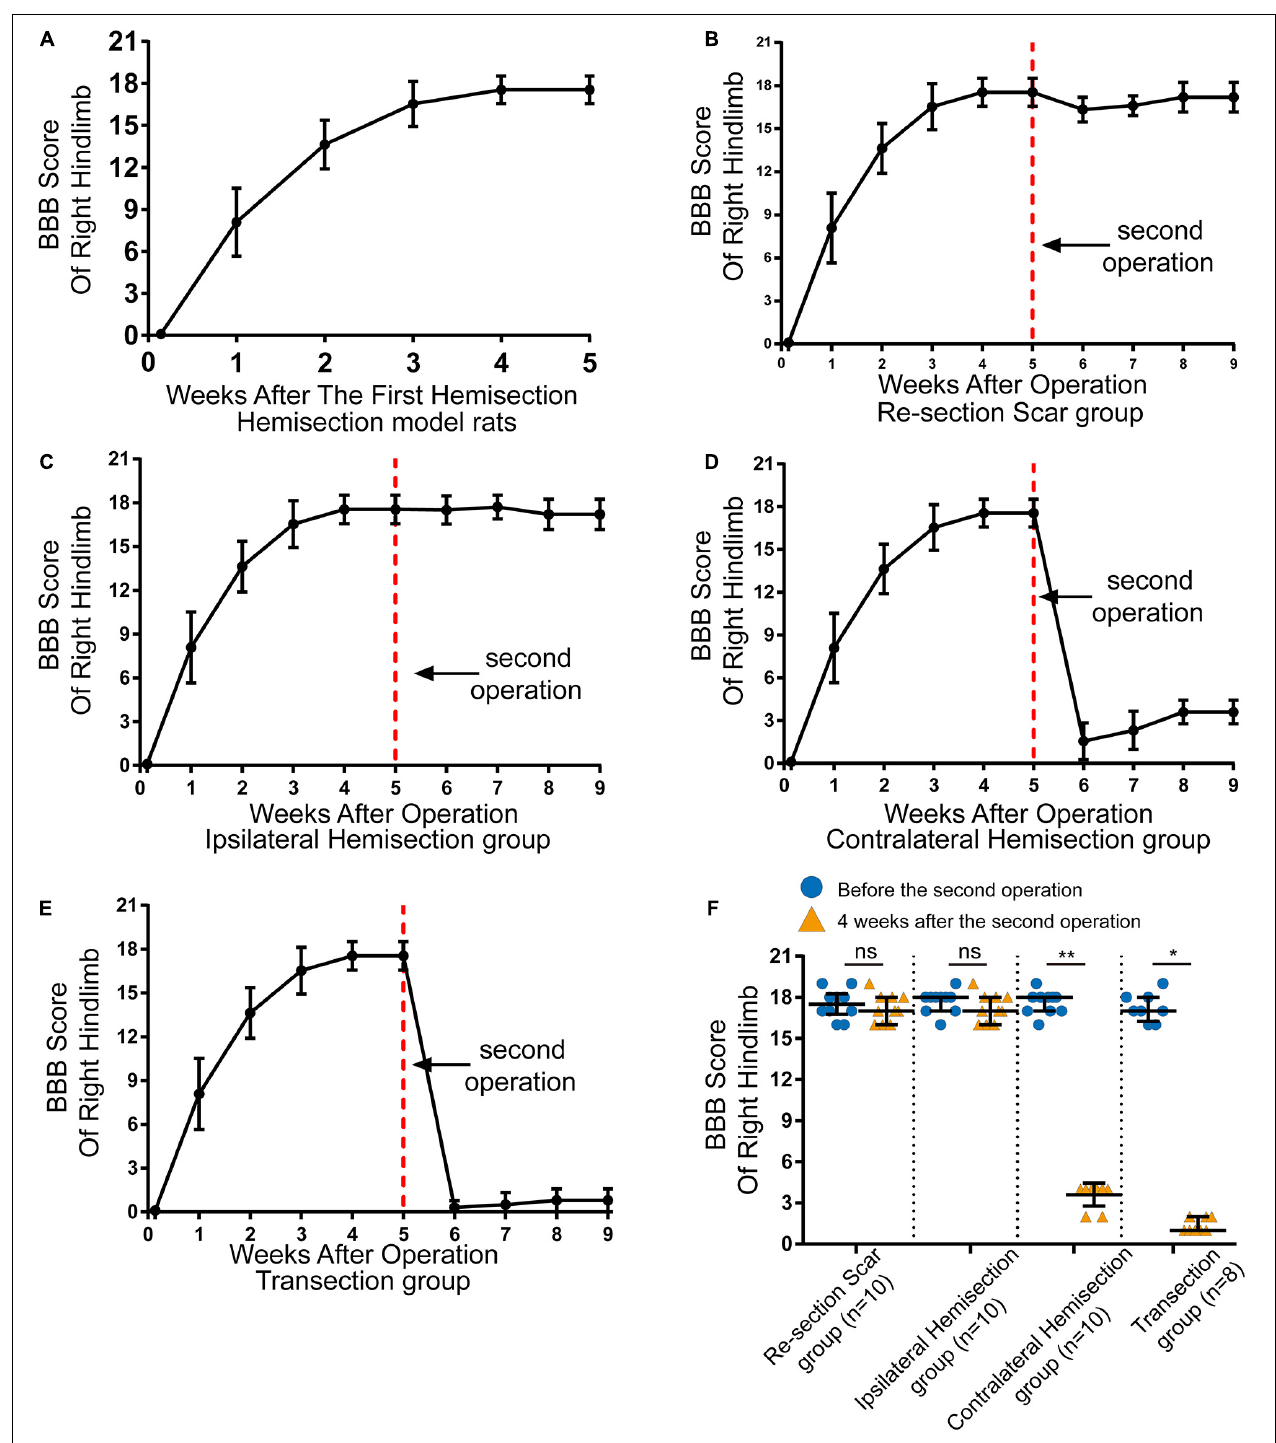
FIGURE 2 | Locomotor assessment for hemisection model rats as well as locomotor changes after the second operation in four groups. (A) The BBB scores of the right hindlimb gradually improved spontaneously in hemisection model rats ( n = 53). (B–E) Trends in BBB scores for each group based on the hemisection model rats: (B) Re-section Scar group ( n = 10), (C) Ipsilateral Hemisection group ( n = 10), (D) Contralateral Hemisection group ( n = 10), (E) Transection group ( n = 8). (F) Comparisons of BBB scores of the right hindlimb before the second operation and 4 weeks after that in each group. The red dotted line indicates the time point for the second operation in each group. N = 10 for Re-section Scar group, 10 for Ipsilateral Hemisection group, 10 for Contralateral Hemisection group, and 8 for Transection group. Bars indicate median, 25th-75th percentiles. * P < 0.05, ** P < 0.01, data are presented as median ± IQR. BBB indicates Basso, Beattie, Bresnahan; ns, no sense; interquartile range,